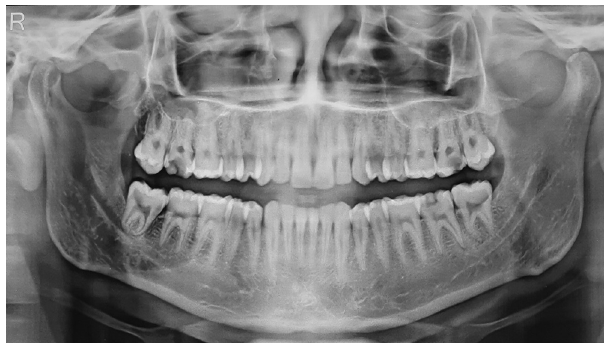
Fig. 2. OPG showing a diffuse area of rarefaction in the mandible.